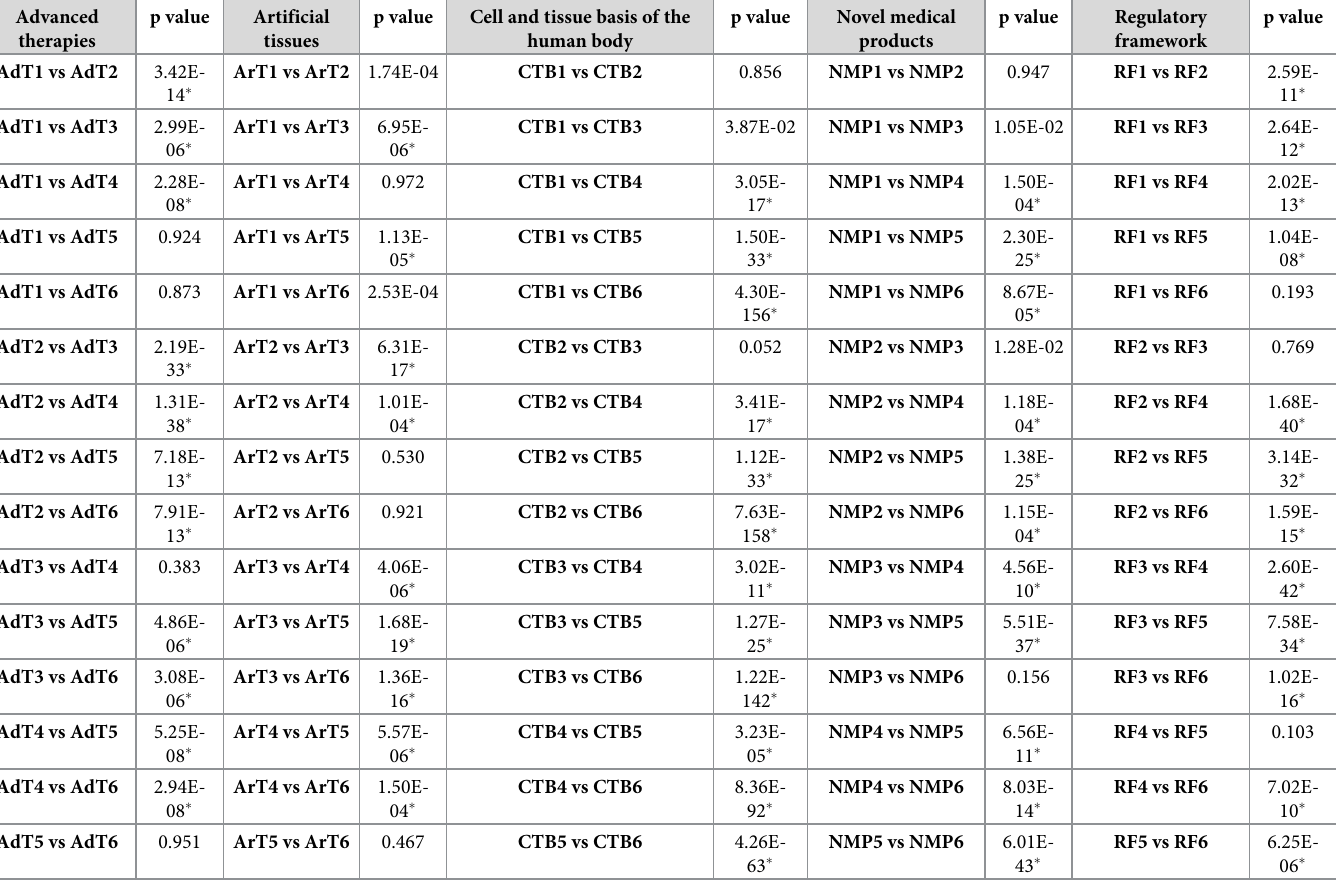
Table 5. Statistical p values for pairwise comparisons of two specific items included in each topic of the conceptual component. Advanced